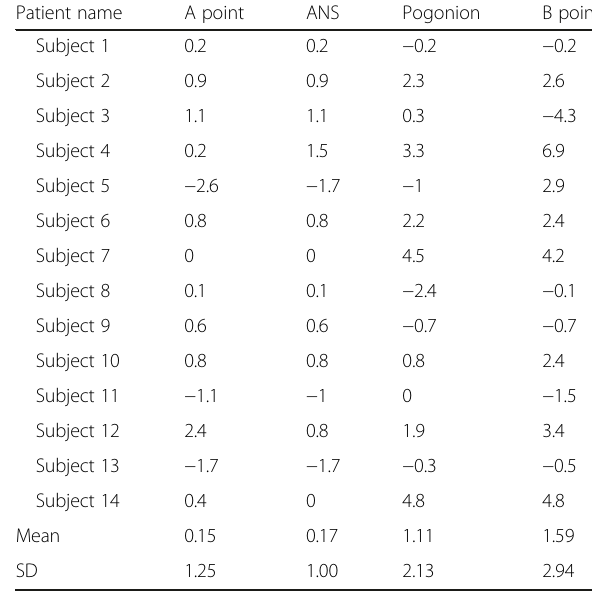
Table 5 Differences between prediction and actual coordinates in the Y -axis